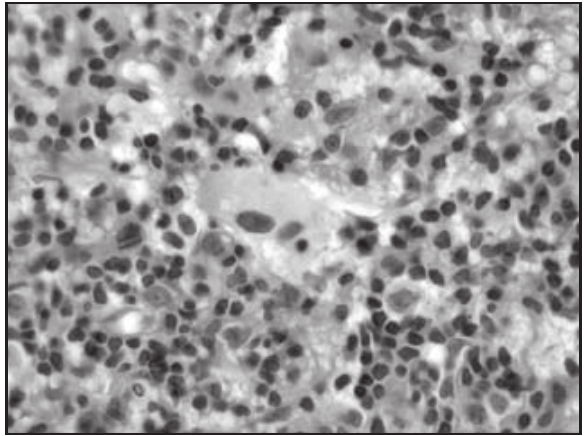
Figure 3 – Two images of emperipolesis (HE 1,000x magnification)